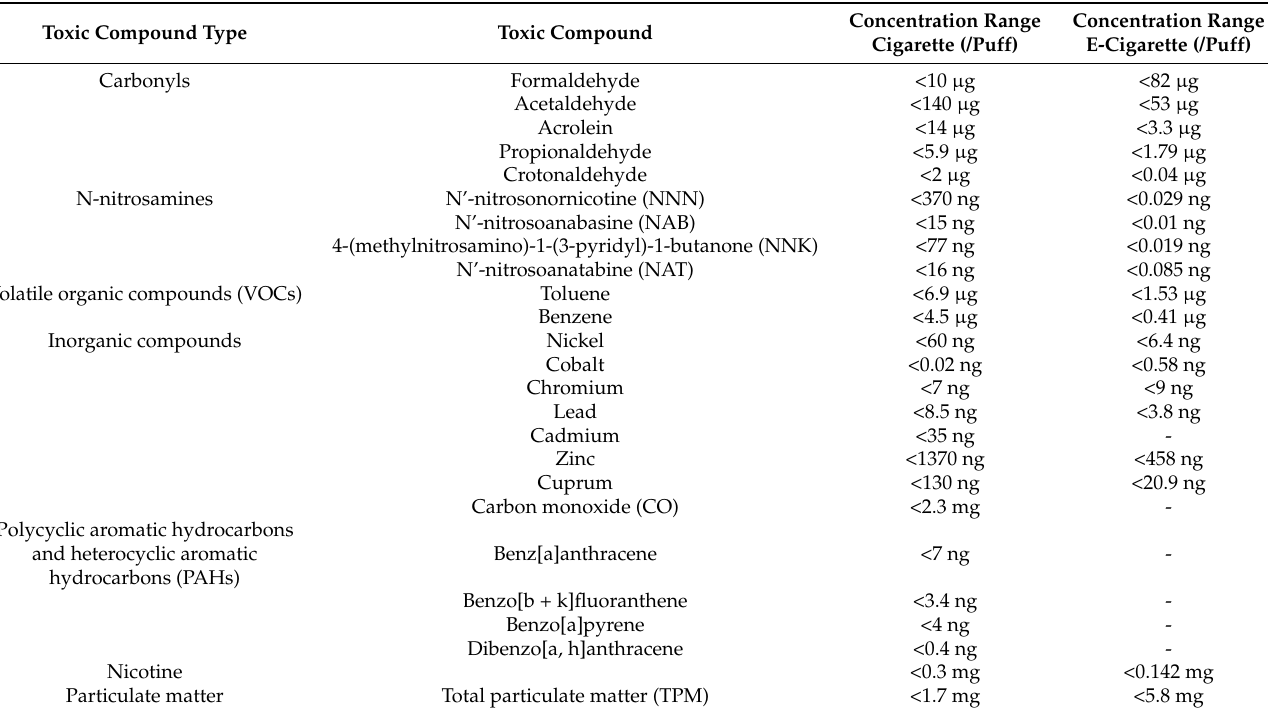
Table 1. Differences in toxic compounds in cigarette and e-cigarette smoke